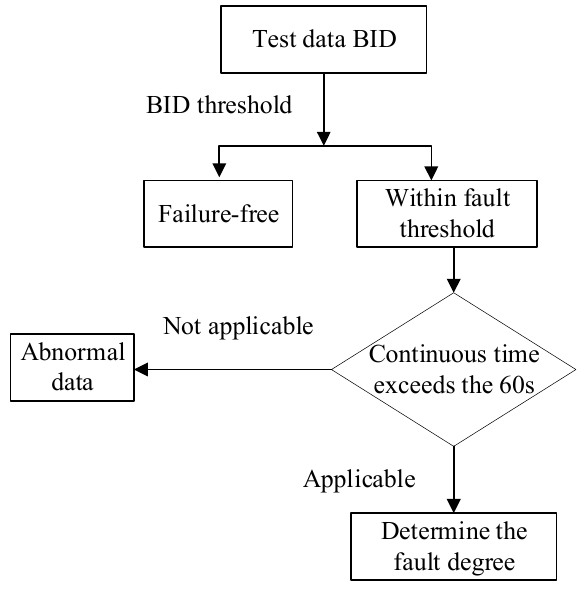
Figure 5. Flowchart of the discriminant rule.